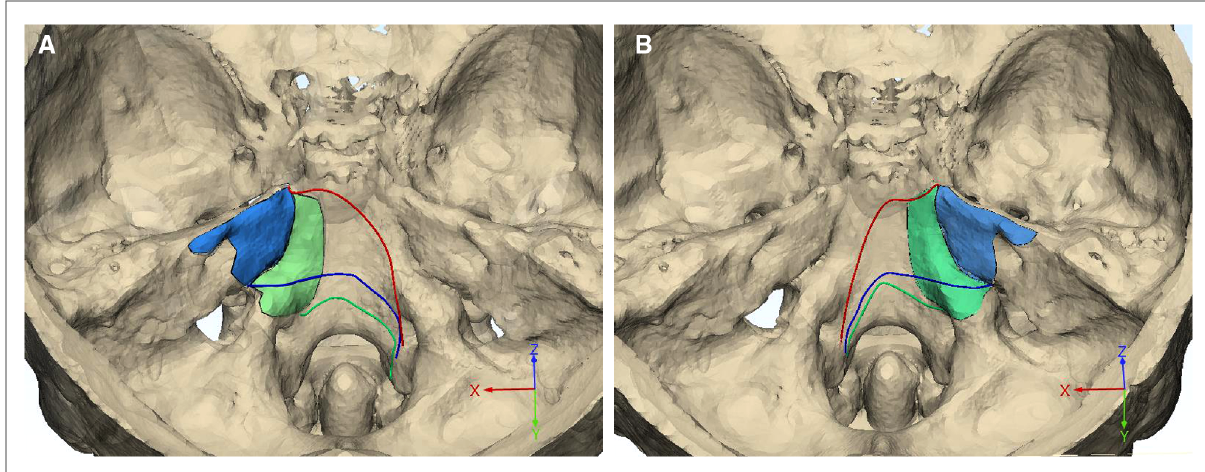
FIGURE 5 Exposure limits of different approaches. The inferior limits for subtemporal (red line), Kawase (blue line), and extended Kawase (green line) approaches are delineated in the skull base of group 1 (A, MA<135°) and group 2 (B, MA ≥ 135°). The debone ranges for the Kawase (blue area) and extended Kawase (green area) approaches are also marked. MA, manipulation angle.